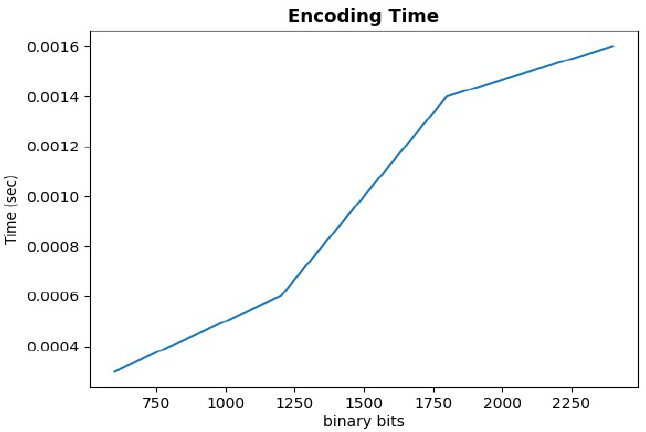
Figure 6. Computational complexity for encoding.